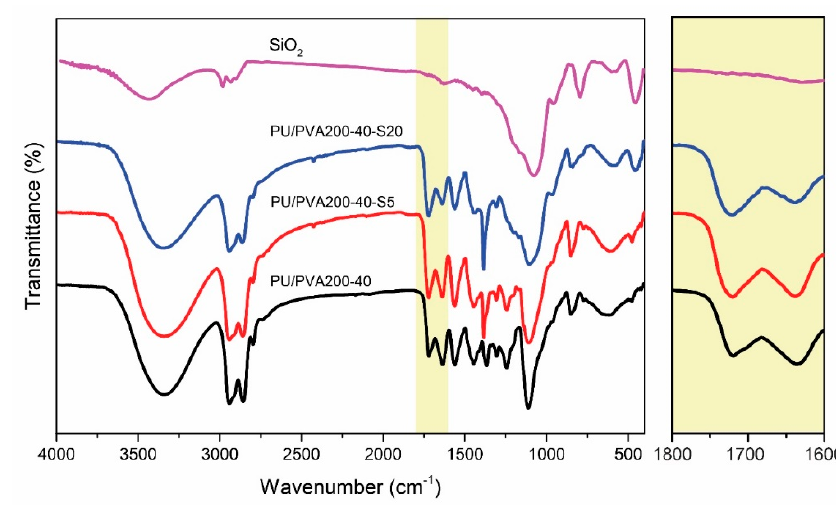
Figure 2. FTIR spectra of silica particles, PU/PVA200, and PU/PVA200/silica MMMs.